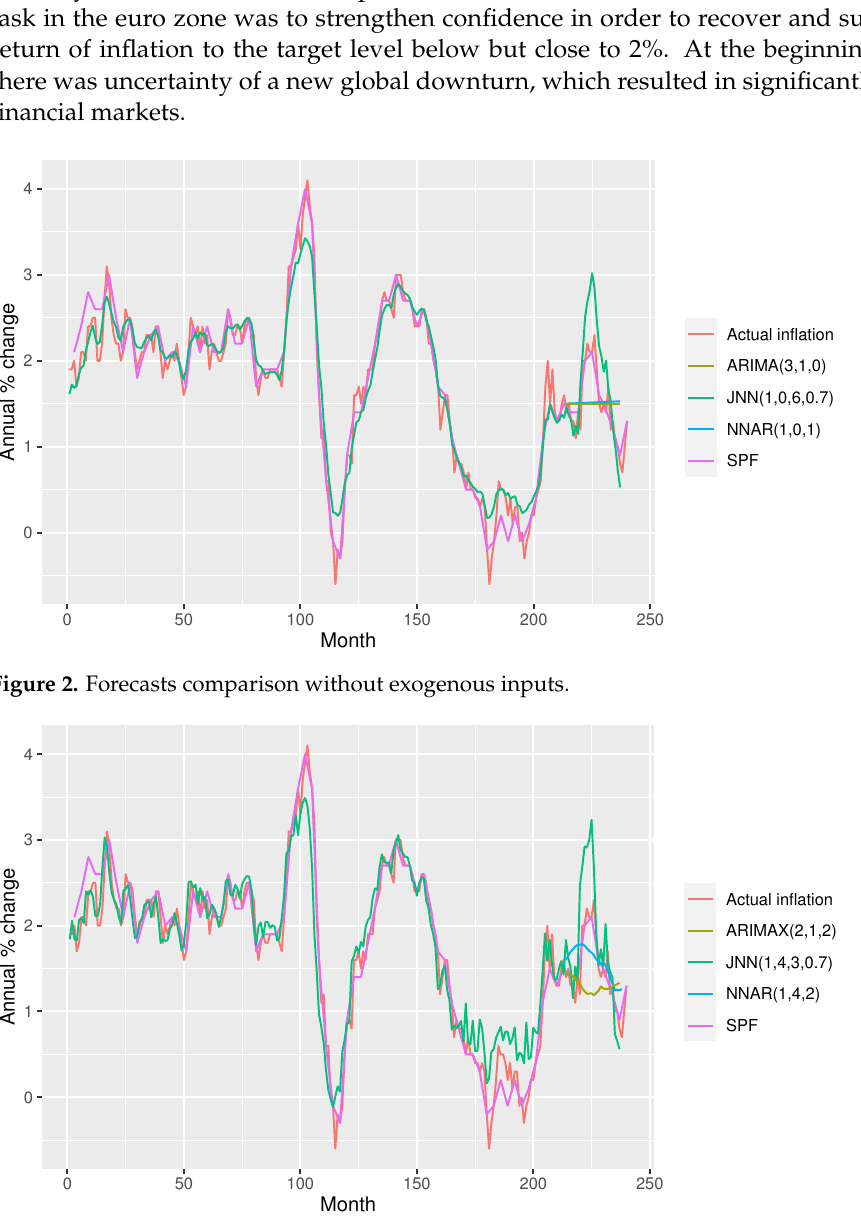
Figure 3. Forecasts comparison with exogenous